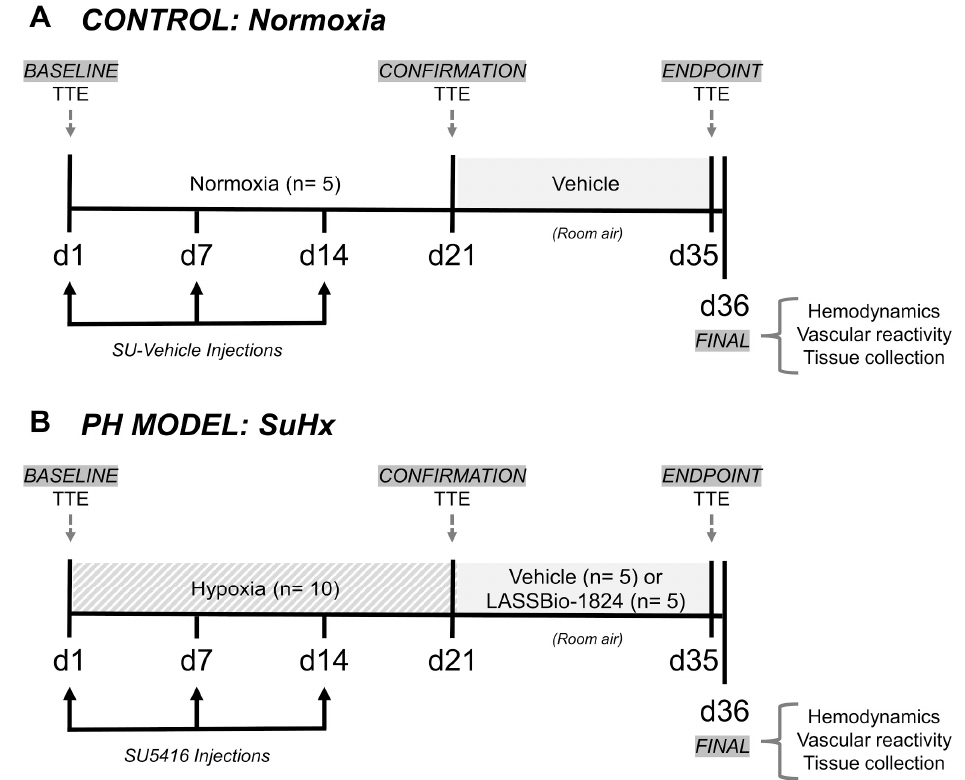
Figure 7. Model induction, therapeutic protocol and measurement schedules. ( A ) Control animals ( n = 5) were maintained in room air (normoxia, FiO2: 21%) throughout the experimental protocol and received both weekly SU-vehicle (i.p.) and after 3 weeks, daily vehicle (DMSO, 100 μ L p.o.). ( B ) SuHx animals were maintained in hypoxic chamber (FiO2: 10%) and received both weekly SU5416 (20 mg/kg i.p.) for 3 weeks and after return to normoxia, daily vehicle (DMSO, 100 μ L p.o., n = 5) or LASSBio-1824 (50 mg/kg p.o., n = 5). TTE, transthoracic echocardiography.